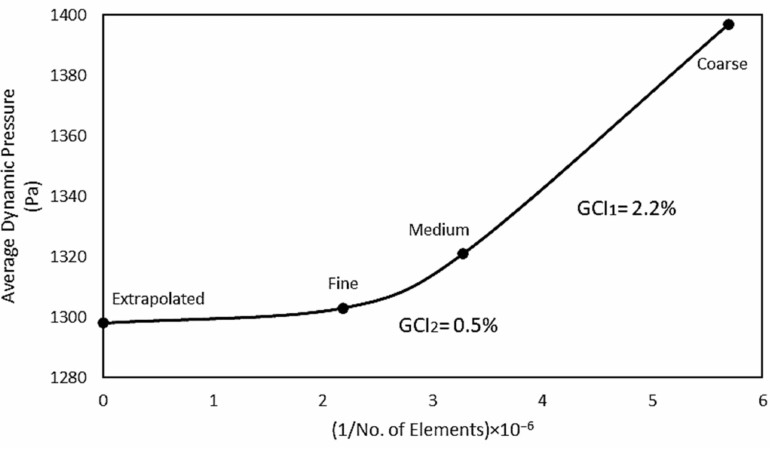
Figure 3. Grid convergence